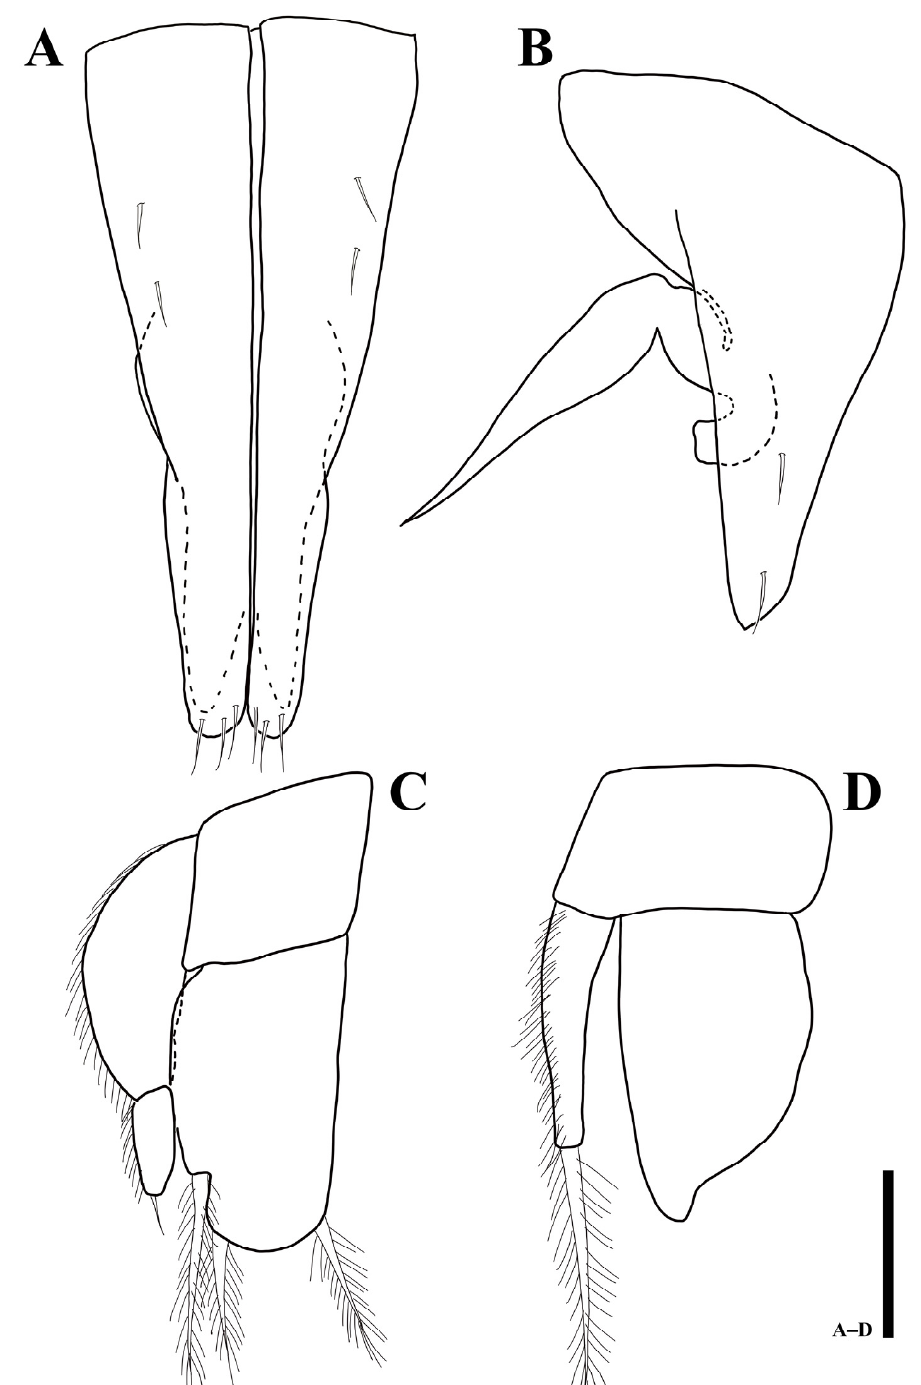
Figure 13. Uromunna jejuensis sp. n. holotype male: ( A ) pleopod 1; ( B ) pleopod 2; ( C ) pleopod 3; ( D ) pleopod 4. Scale bars = 100 μ m.